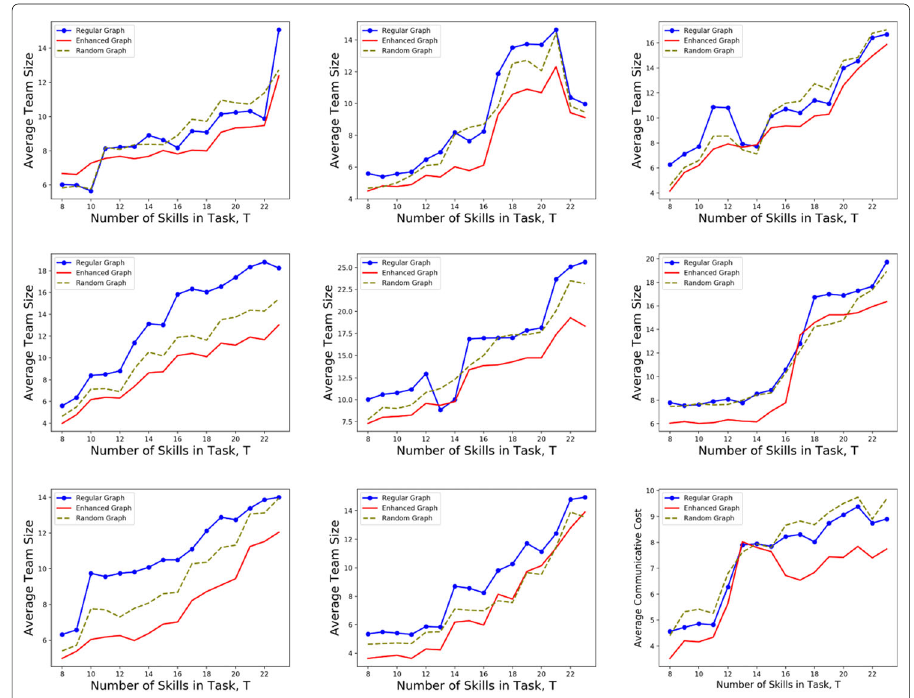
Fig. 10 Average Cardinality of Teams for Differing Task Sizes — IBM